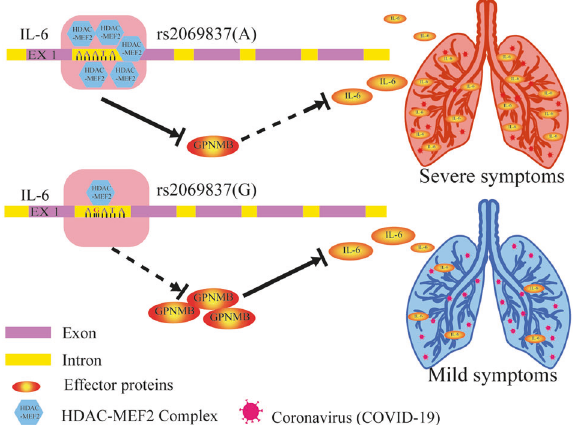
Fig. 4 A proposed model for the regulatory mechanism of rs2069837 on the expression of IL6 involved in COVID-19. There was higher expression of MEF2 expression and lower GPNMB expression in IL6 rs2069837 AA genotype group, leading to IL6 up- regulation and severe COVID-19 development. IL6 rs2069837 GG genotype could decrease MEF2a binding and increase GPNMB expression, resulting in lower IL6 expression and prevention of severe